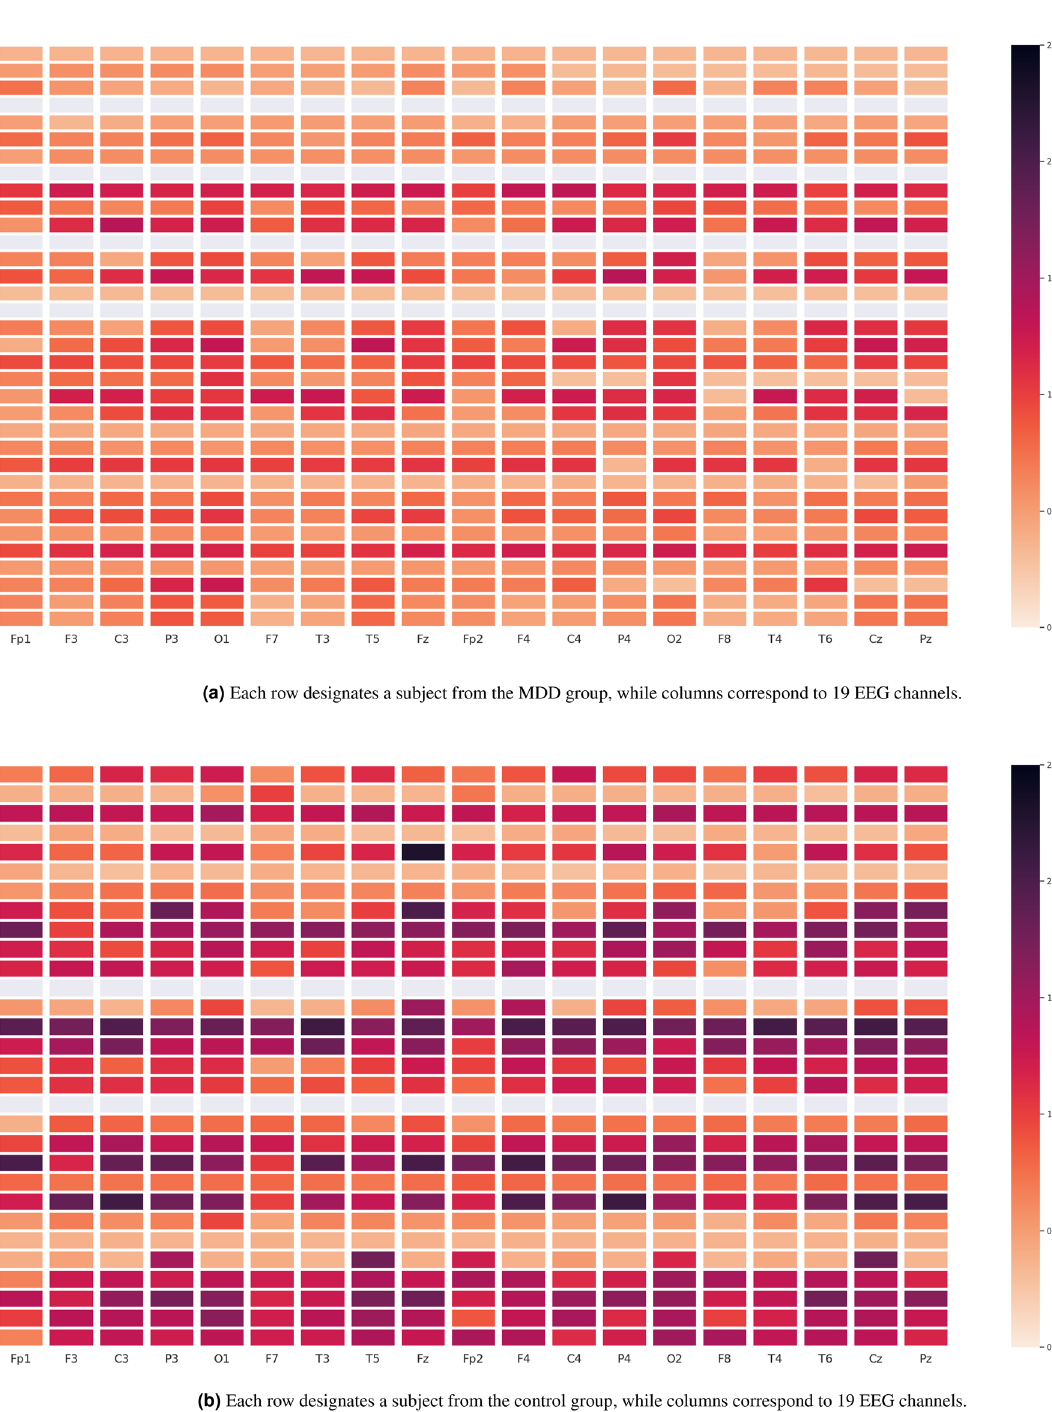
Figure 7. Heat maps of the differential entropy of action potential distributions for experiments with